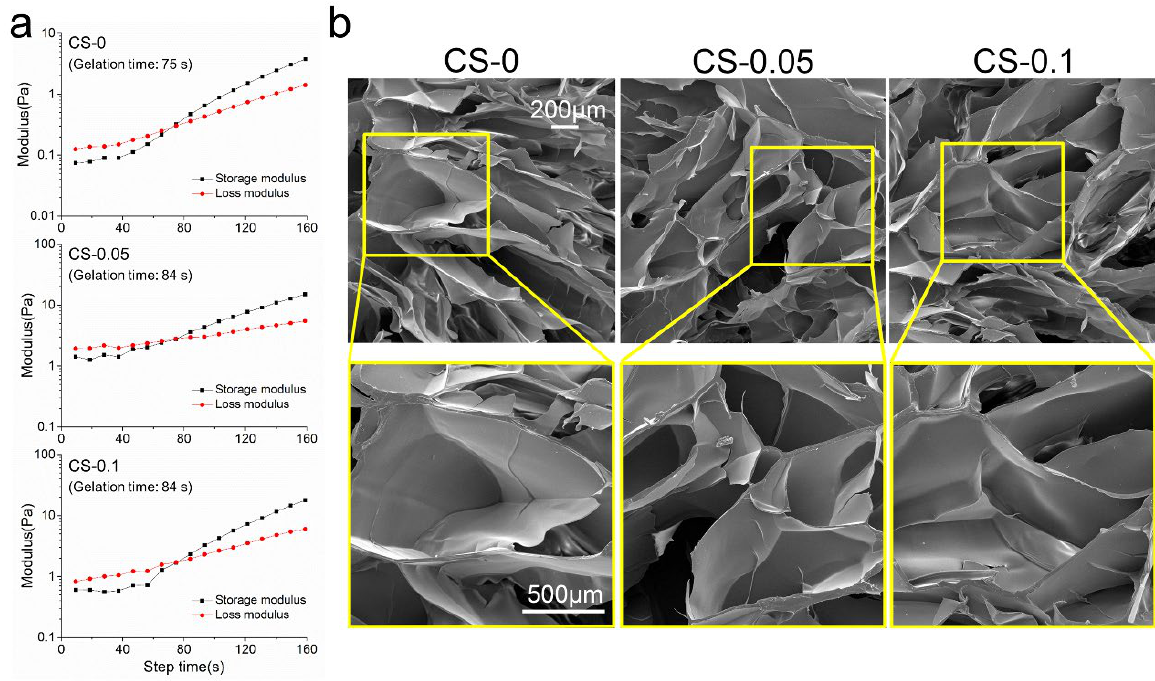
Figure 2. ( a ) The rheological behaviors, and ( b ) SEM images of different hydrogels.